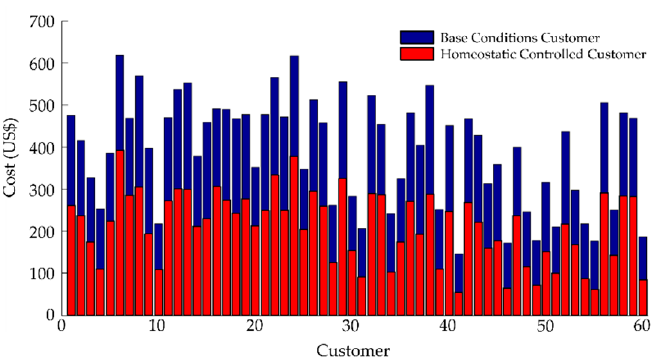
Figure 9. Annual energy cost per client under B criterion.